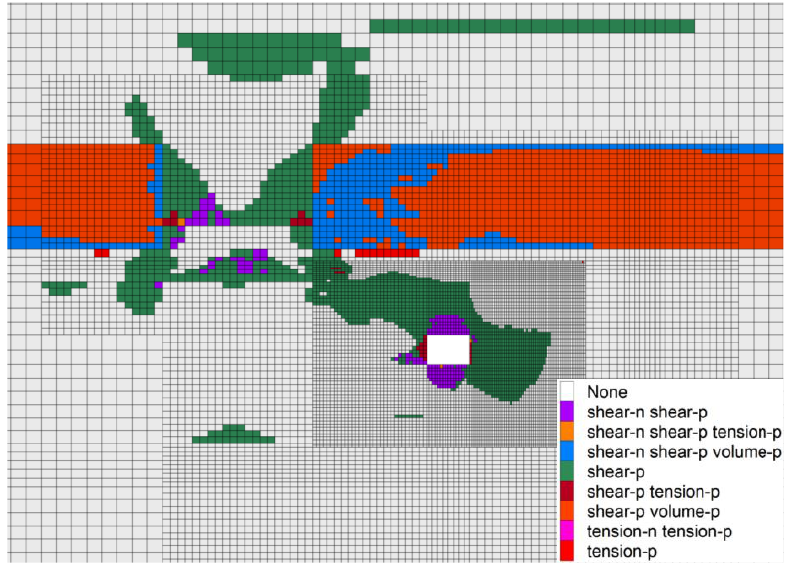
Figure 11. Plastic zone distribution cloud map when the roadway excavation leaves top coal bot- tom coal.